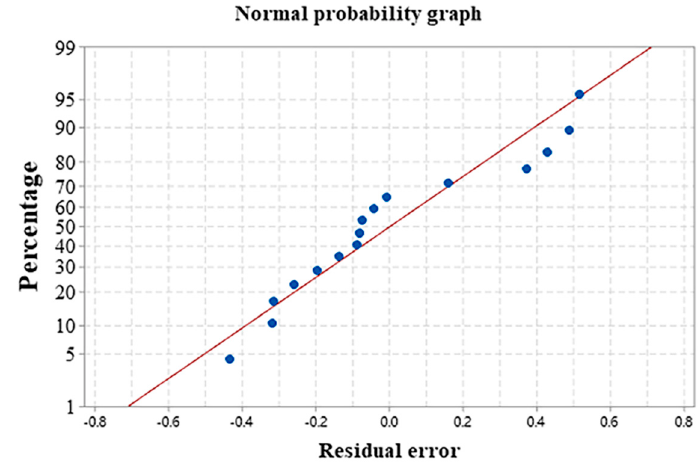
Figure 11. Normal hardness distribution. Table 6. Variance analysis of the hardness.